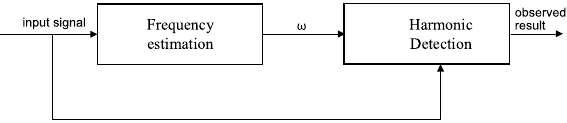
Figure 2. Harmonic detection